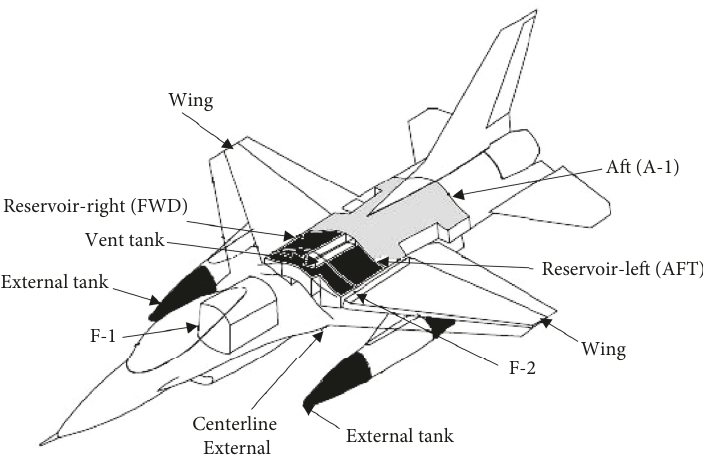
Figure 30: High fuel locations.